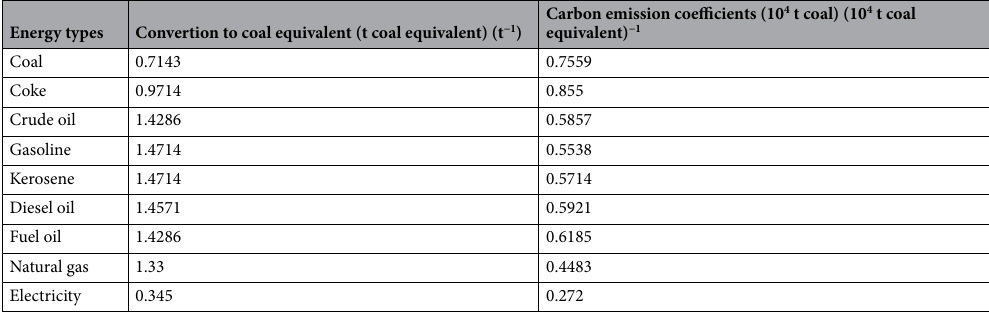
Table 1. Carbon emission coefficients for different energy types. * Conversion coefficient for natural gas is t/ ten thousand m 3 . Conversion coefficient for electricity is t/ten thousand Wh.